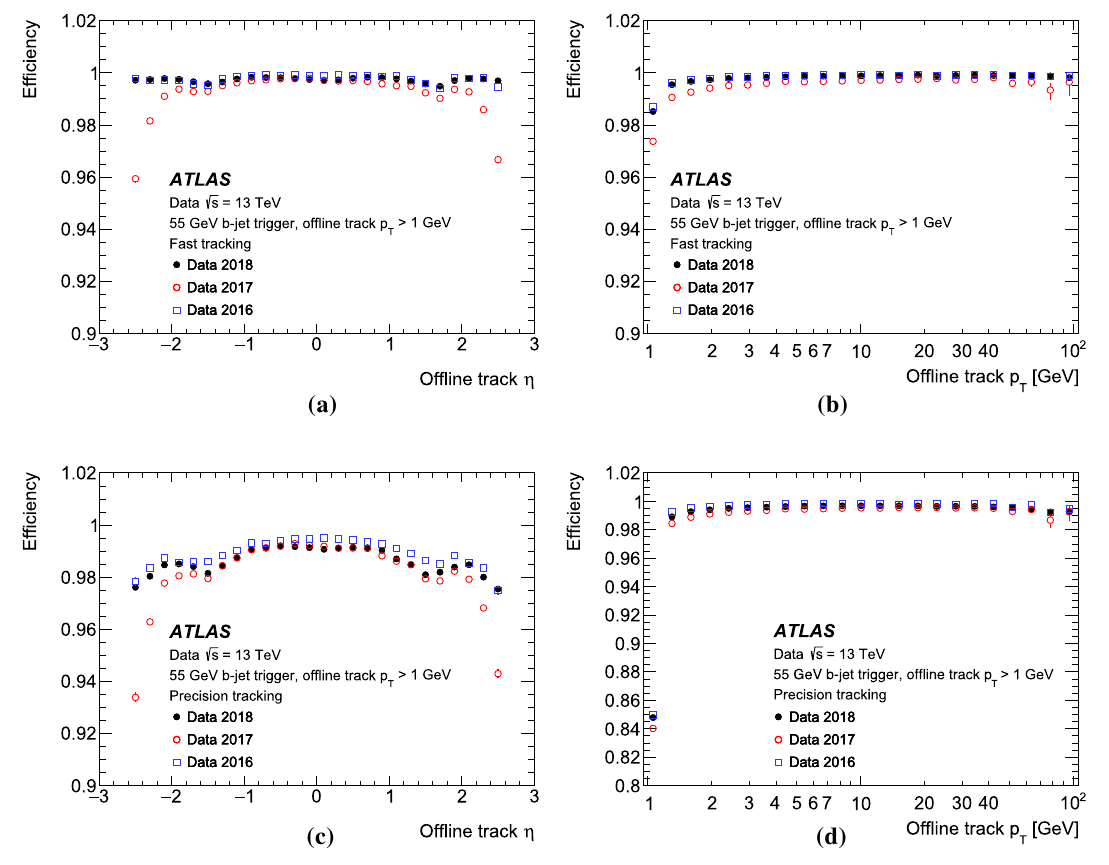
Fig. 39 The b -jet second stage tracking performance efficiency differences between 2016, 2017, and 2018